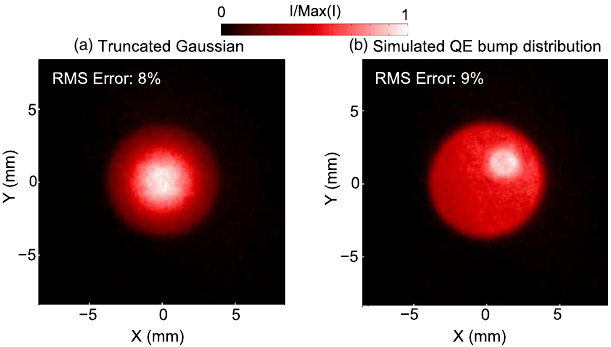
FIG. 8. (a) Electron beam distribution created with beam feedback: A truncated Gaussian. (b) A beam shape for a hypothetical photocathode with a local QE dip, thus requiring a local maximum on the laser power (electron beam shown).